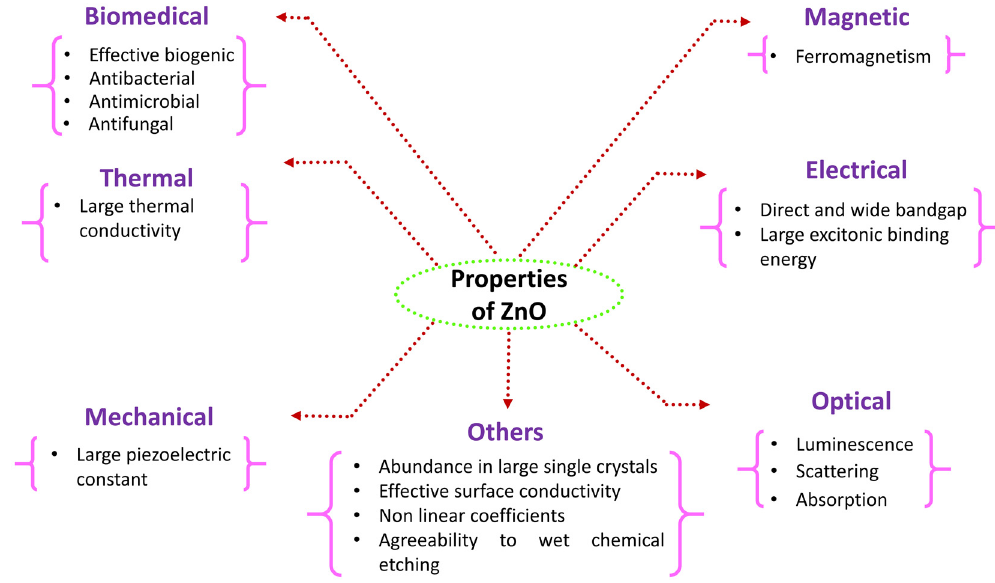
Figure 5: Categorization of properties on the basis of their